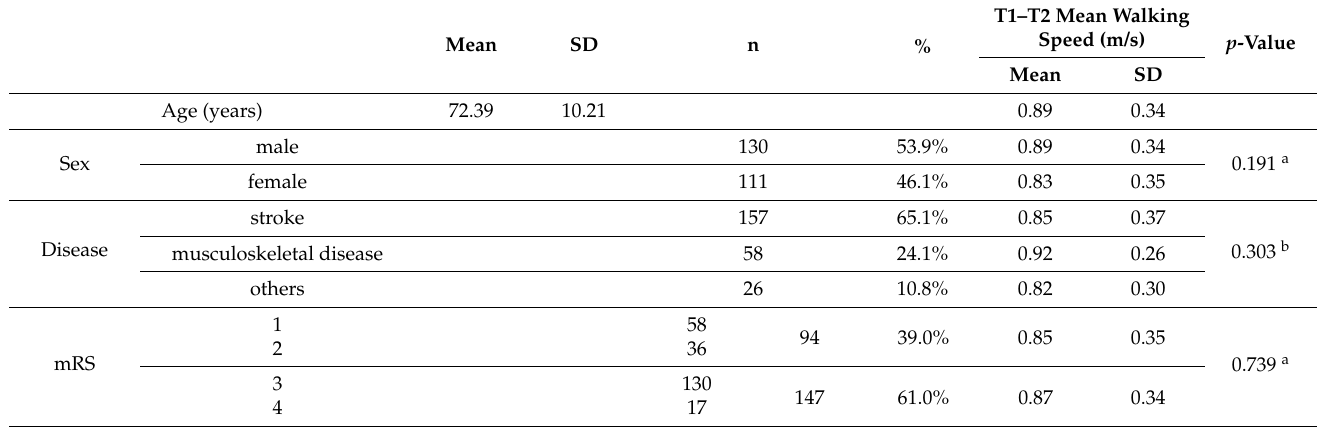
Table 1. Demographic data of the 241 daycare users. mRS: modified Rankin Scale, SD: standard deviation, a: t -test, b: One-factor